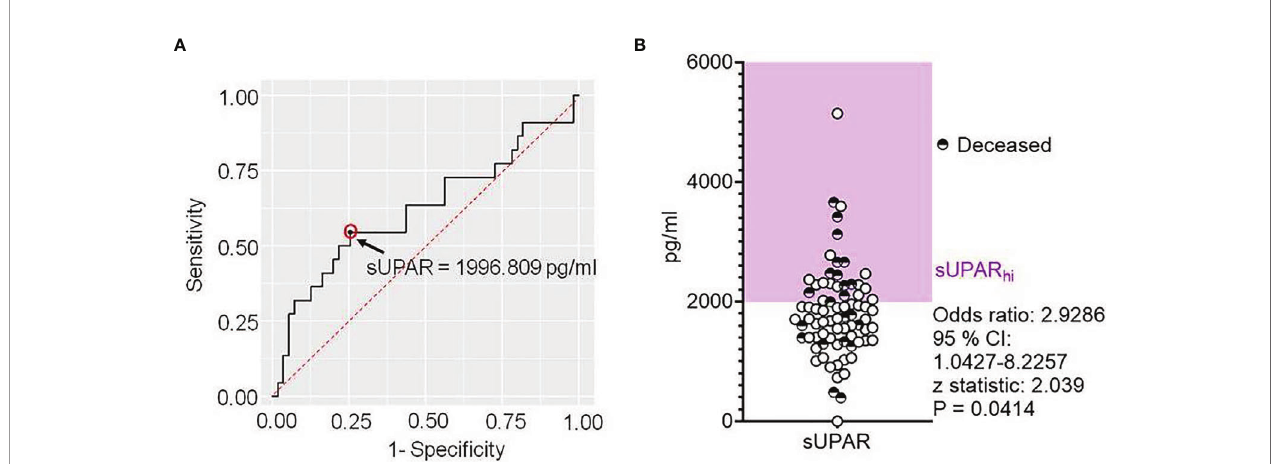
FIGURE 6 | Deriving a cutoff for the plasma level of soluble uPAR linked to disease outcomes in severe COVID-19. (A) Receiver operator characteristic curve for plasma levels of suPAR as a predictor for fatal outcomes in severe COVID-19 patients. (B) Scatter plot showing the plasma level of suPAR for individual patients, also marking their fi nal disease outcomes. The odds ratio was calculated for suPAR hi patients to meet with fatal